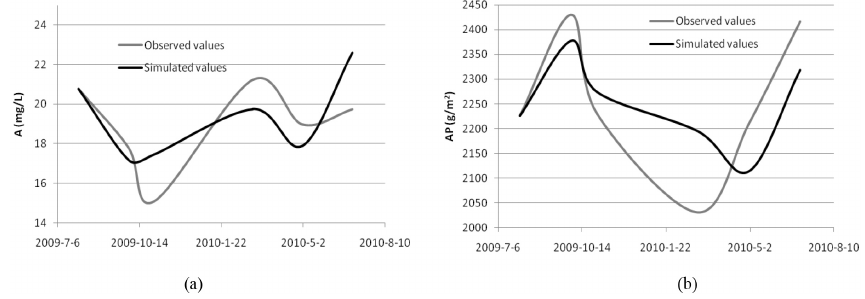
Figure 13. Calibration results for phytoplankton biomass (a) and aquatic plant biomass (b) at site 8.